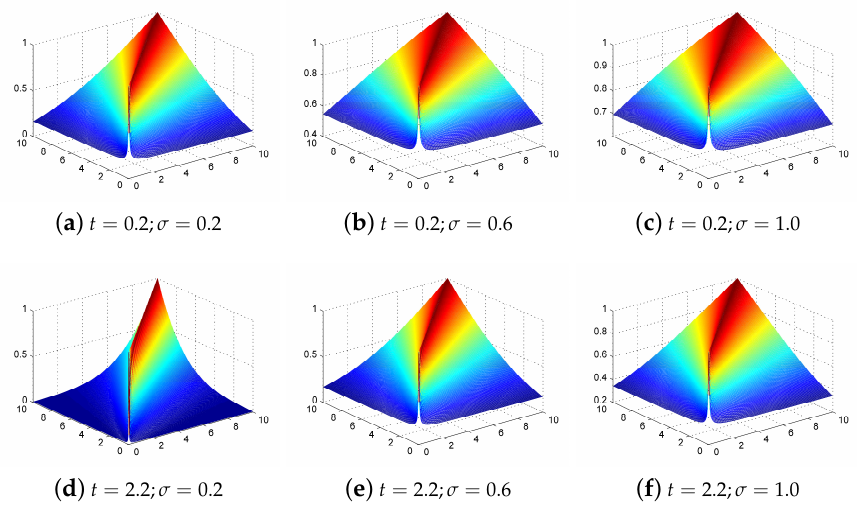
Figure 3. Power-SAM-RBF kernel characteristics with different parameters of t and σ .